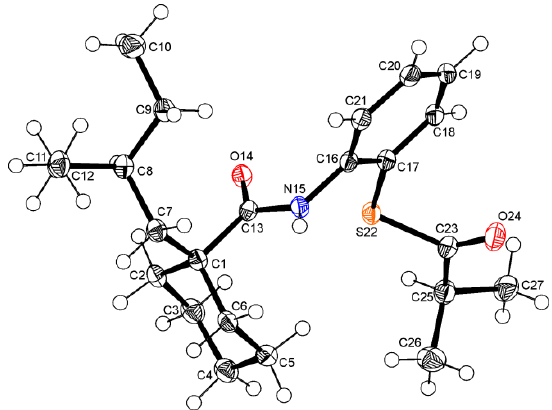
Figure 2. O RTEP plot of dalcetrapib (thermal ellipsoids drawn at the 50% level).